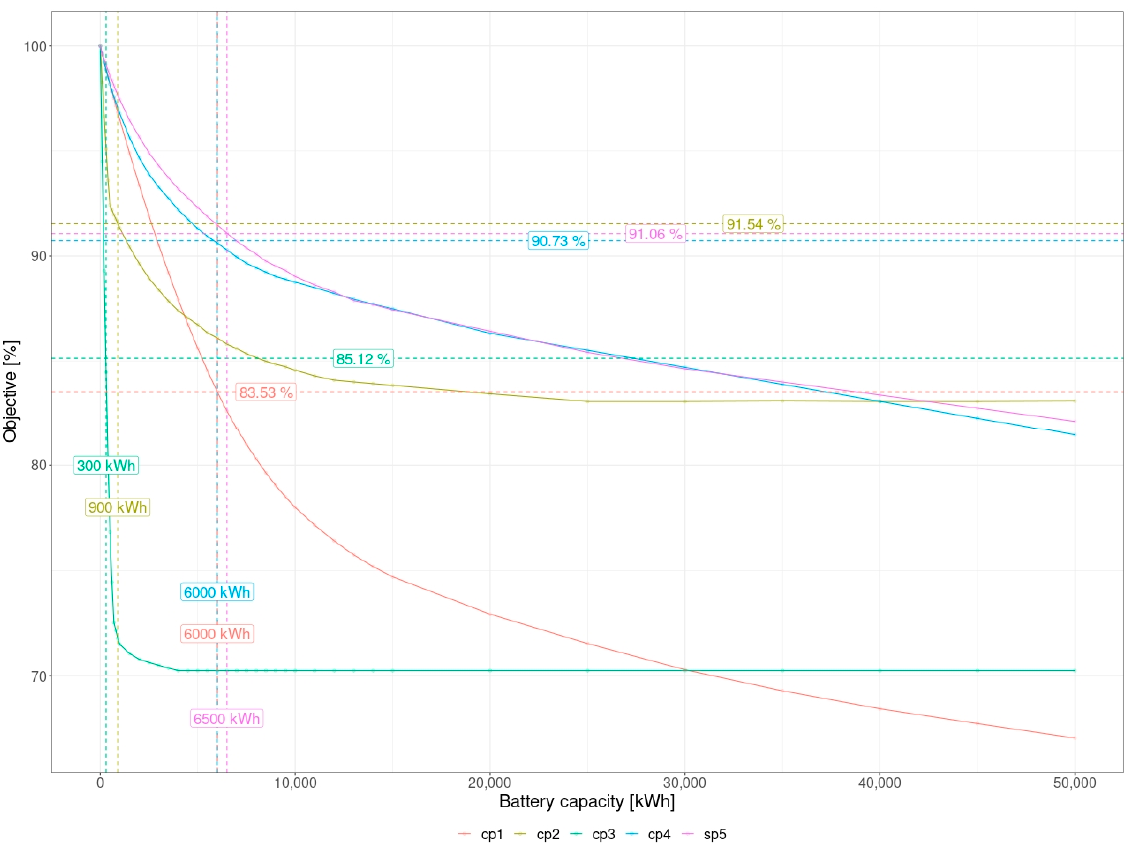
Figure 1. Simulation results of the optimization effect of the sum of energy taken from the network and energy remaining in the virtual network deposit after the billing period, depending on the battery capacity for individual energy coopera- tives.